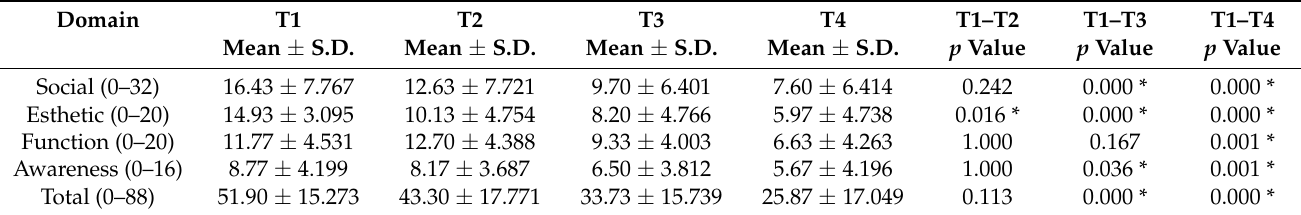
Table 3. The OQLQ score (total and subdomain) at each stage of the SFA group, compared using the Friedman and post hoc Dunn